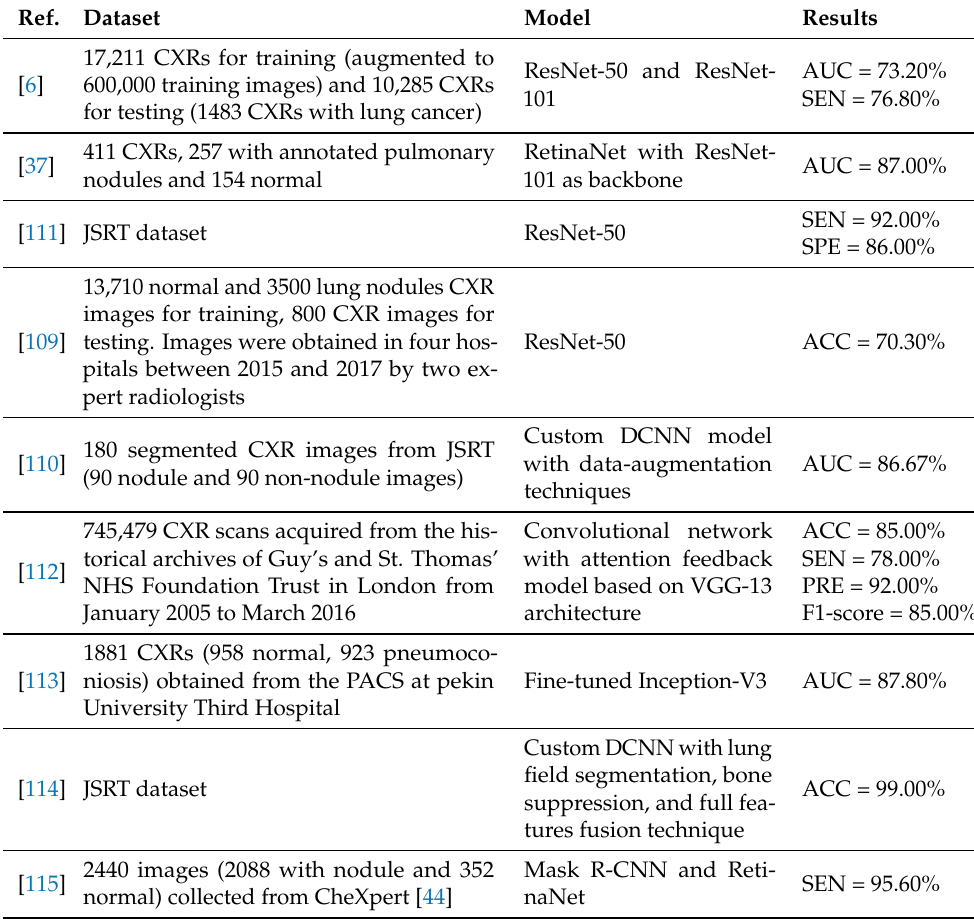
Table 8. Summary of different DL techniques for pulmonary nodule